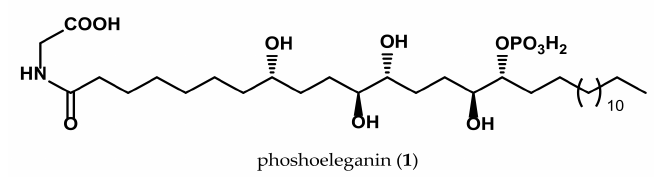
Figure 1. Structure of phosphoeleganin ( 1